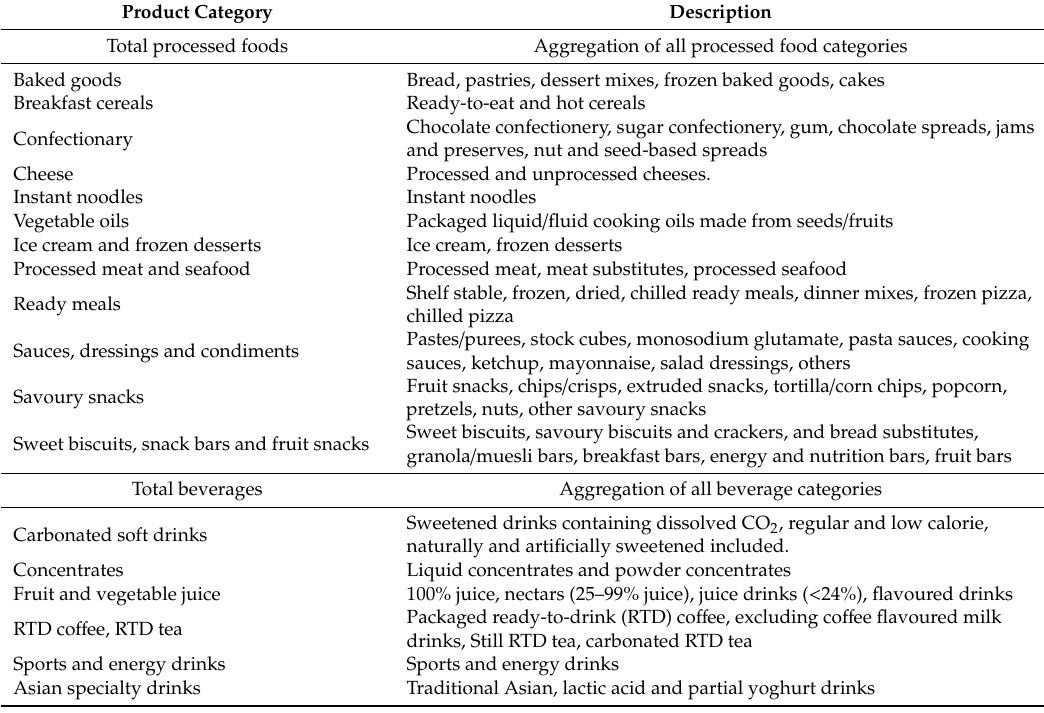
Table 1. Included processed food product categories and